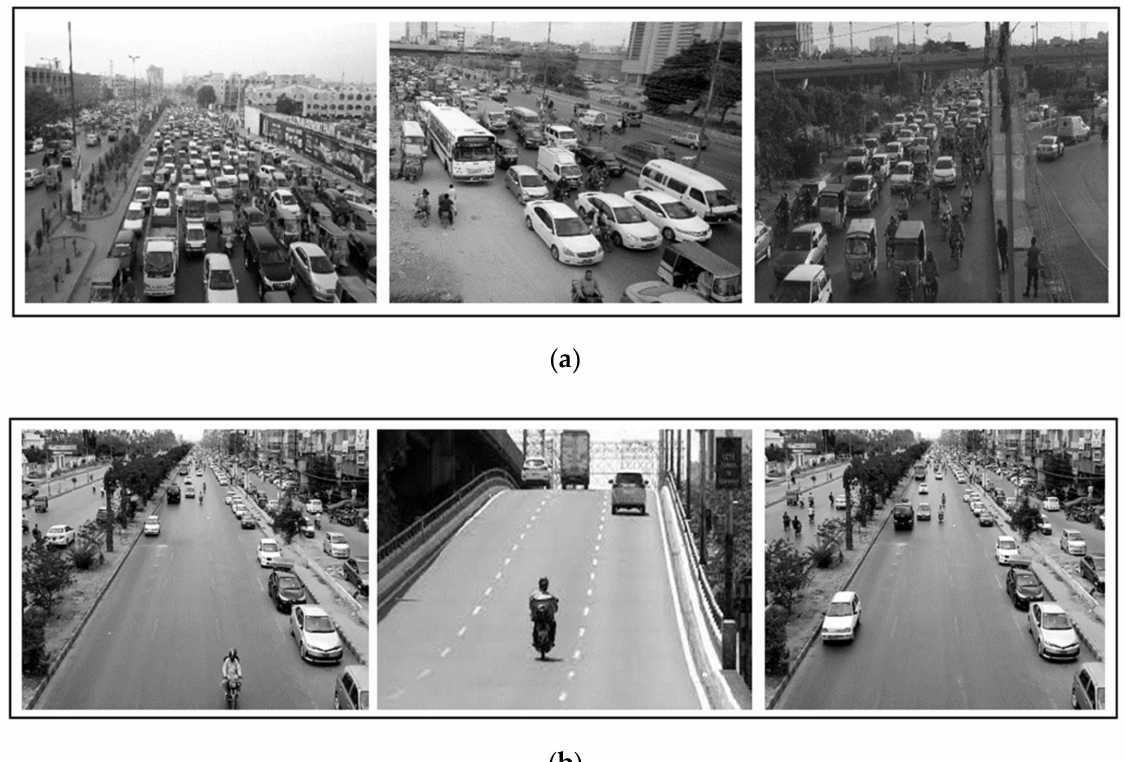
Figure 1. ( a ) Samples images of congestion. ( b ) Samples images of no congestion or little